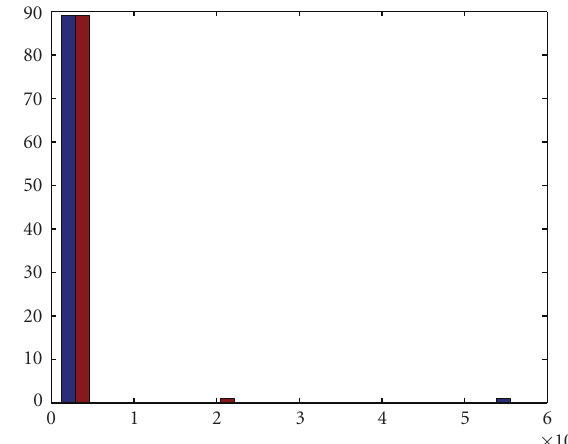
Figure 3: The darker line is the trajectory of a robot trying to reach the goal (@ at the top of the figure). It must achieve this goal while avoiding the moving obstacle (lighter line).